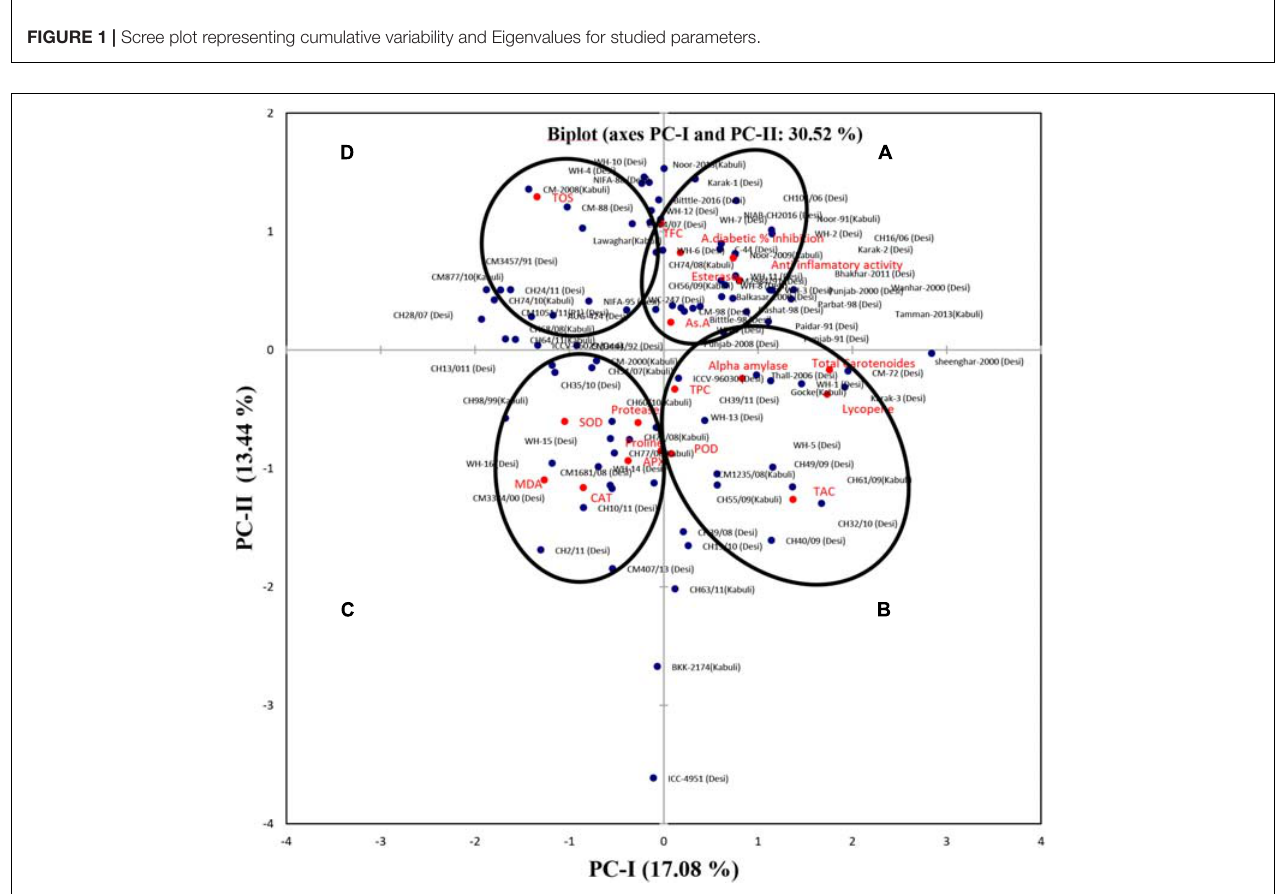
FIGURE 2 | Bi-plot of chickpea genotypes for the first two principal components. Based on the angle between the traits, the biplot was categorized into four groups ( A, B, C , and D